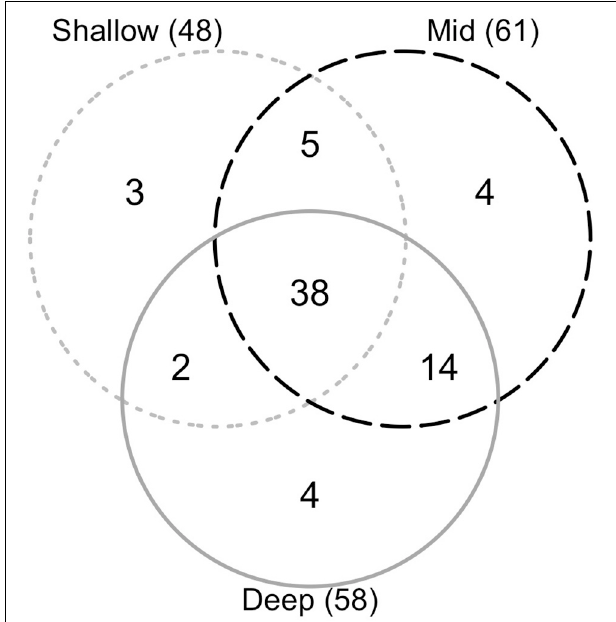
FIGURE 5 | Venn diagram showing unique and shared species in shallow, mid and deep rocky reefs. Numbers inside parentheses are total number of species found at each depth.